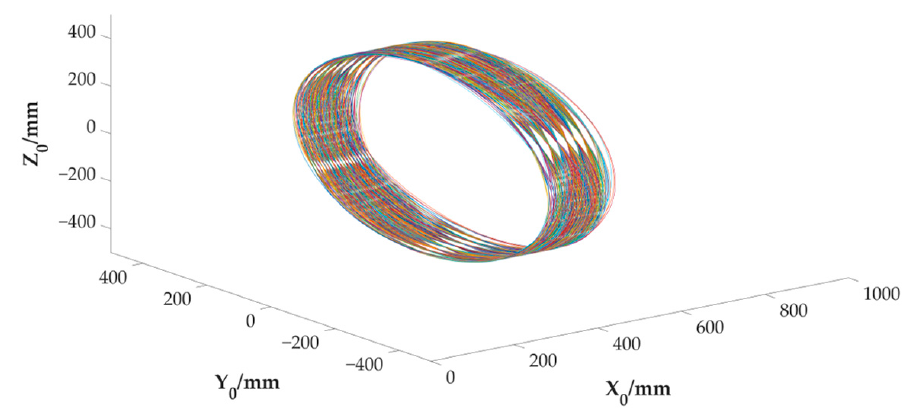
Figure 14. The workspace of the 3SPS + 3PRS PM.